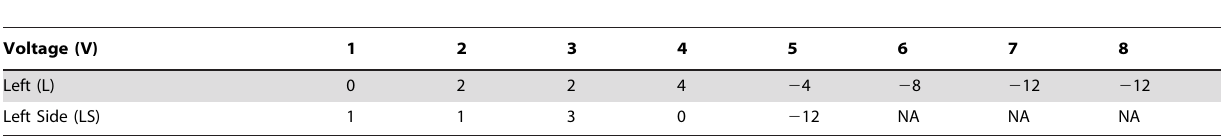
Table 1. Electric potentials on the electrodes of top left (L) and left side (LS) rows.